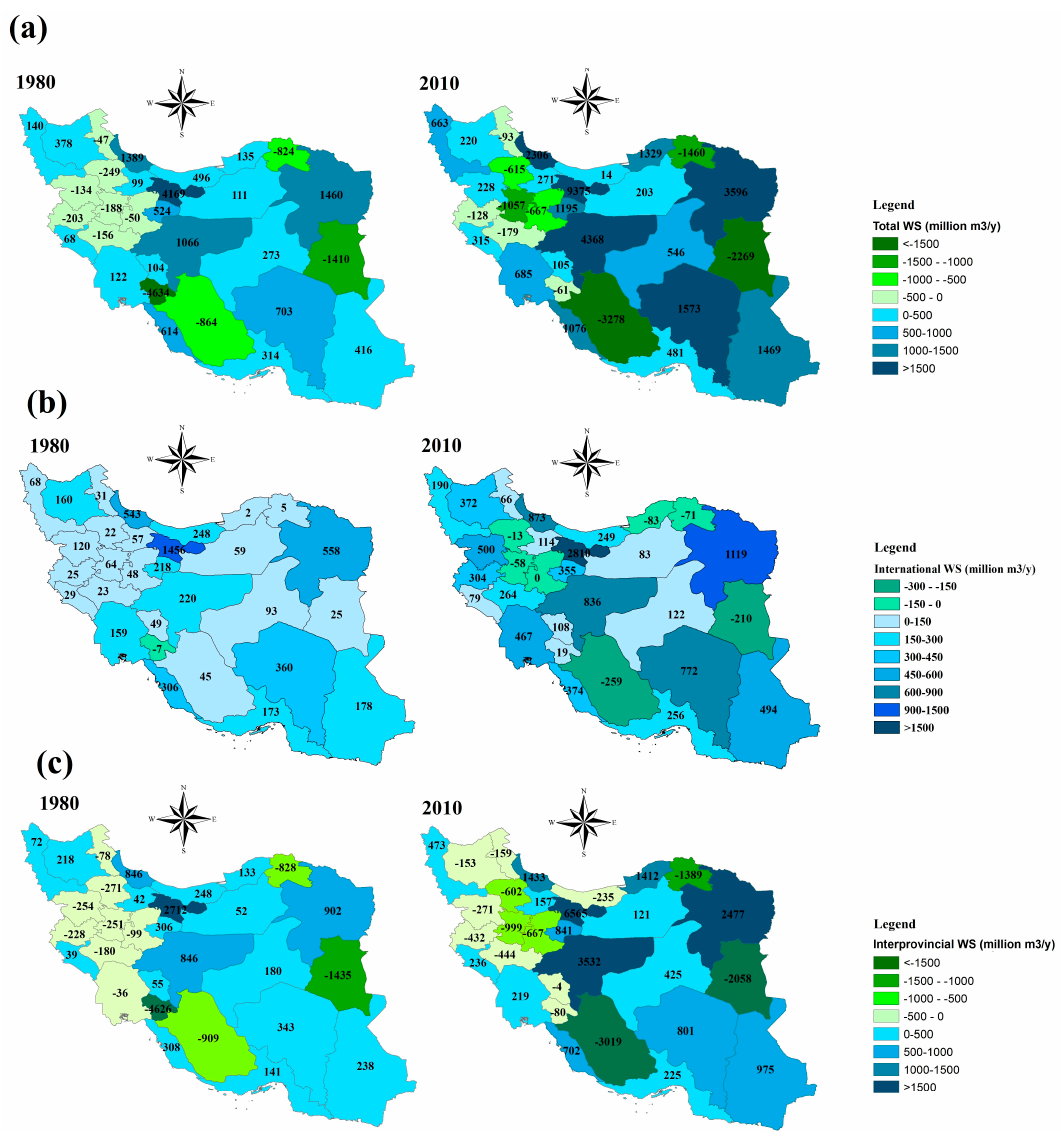
Figure 13. Total (green plus blue) water saving (WS) as a result of total ( a ), international ( b ), and interprovincial ( c ) crop trade, per province, in 1980 ( left ) and 2010 ( right ).